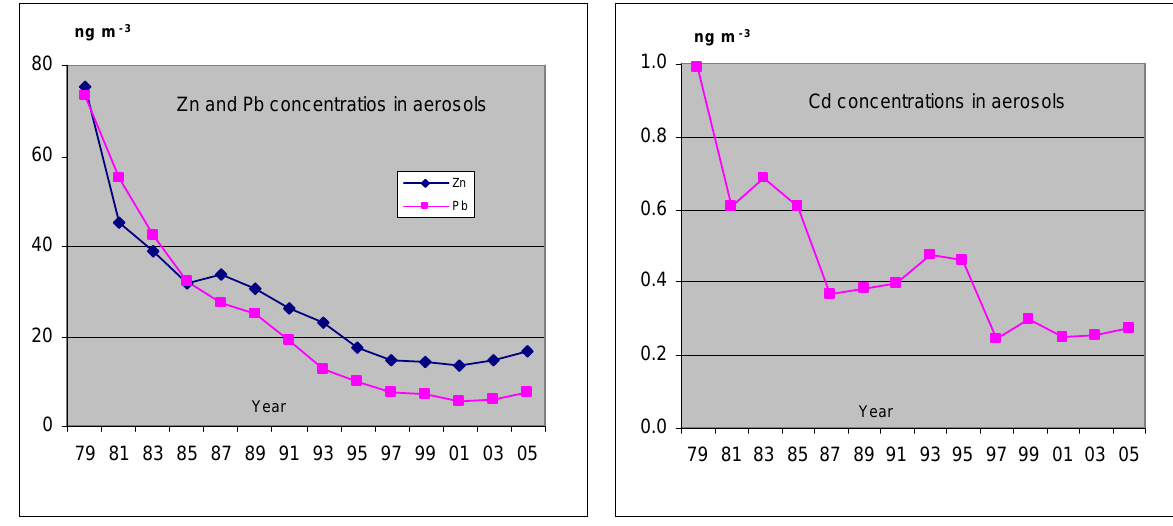
FIGURE 2 . Yearly average concentrations of lead (Pb), zinc (Zn), and cadmium (Cd) measured in rural forests in Denmark since 1979. The average values are based on daily samples from one to four